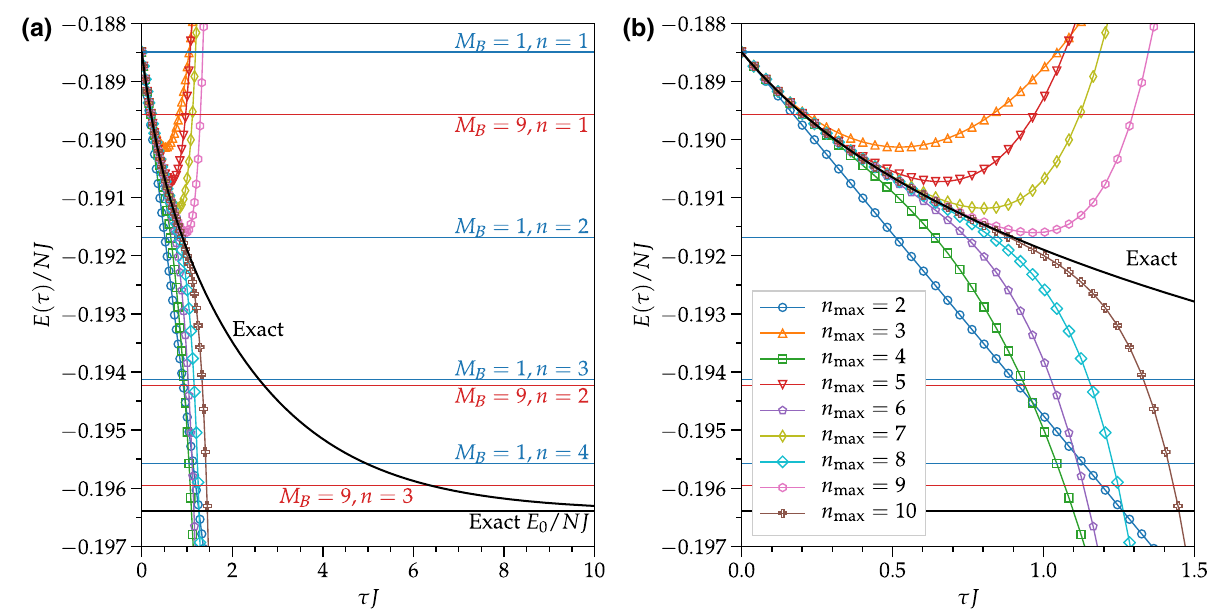
FIG. 22. (a) Energy expectation value E (τ) with respect to the exact imaginary-time evolution of | (cid:6) VQE (cid:3) (black solid line) and the (τ) with various truncation order n τ for the spin-1/2 Heisenberg CMX energy E n max (symbols) as a function of the imaginary time max model on an N = 16 qubit ring given in Eq. (65). For comparison, the energies estimated with the Krylov-subspace diagonalization involving | (cid:6) VQE (cid:3) as a reference state with M B = 1 for 1 (cid:3) n (cid:3) 4 (blue horizontal lines) and with M B = 9 for 1 (cid:3) n (cid:3) 3 (red horizontal lines) are shown. These are the same results in Fig. 5. Here, n = dim K n / M B , i.e., the dimension of the Krylov subspace K n per block size M B (for details, see Sec. V C). (b) Same as (a) but an enlarged plot for 0 (cid:3) τ J (cid:3)